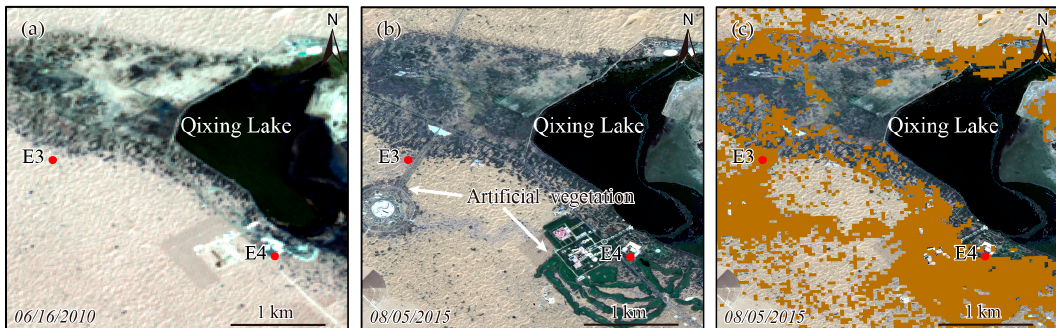
Figure 11. Human-induced desertification reversion and its validation. ( a ) Advanced Spaceborne Thermal Emission and Reflection Radiometer (ASTER) image acquired in 2010; ( b ) Gaofen-2 (GF-2) image acquired in 2015; ( c ) the areas identified in this study as experiencing human-induced desertification reversion (brown color) during 2010 to 2015. The red dots marked E3 and E4 show the locations of the photos used in Figure 12a,b.